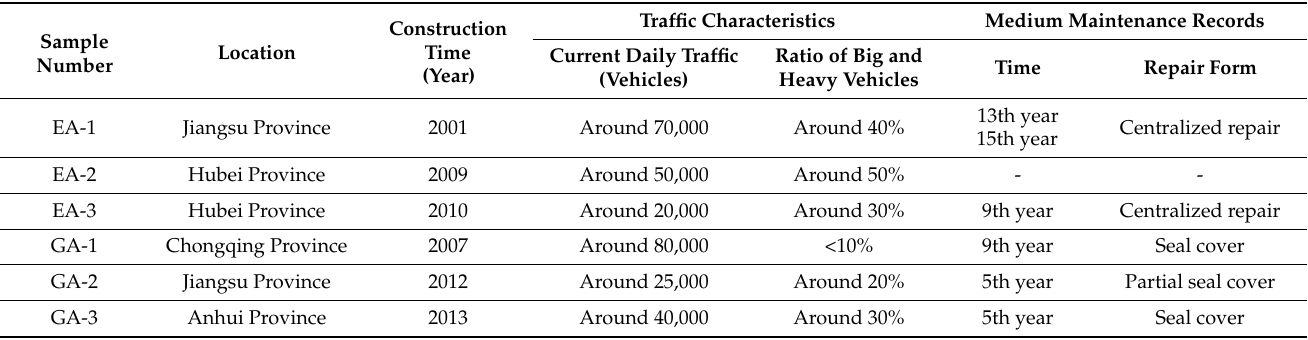
Table 1. Basic information from the investigation.